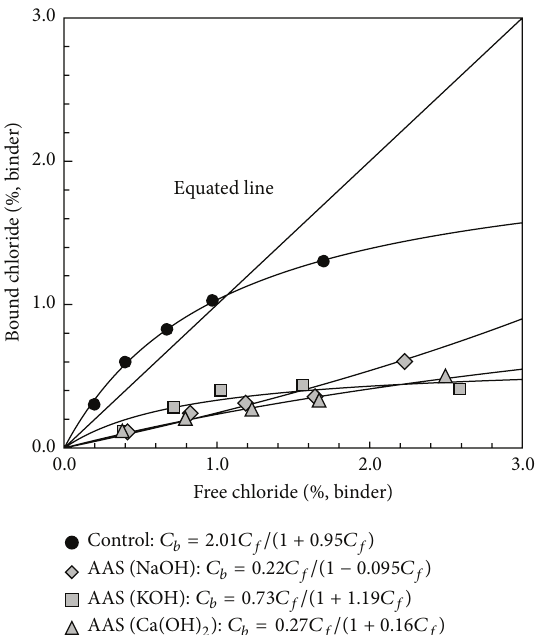
Figure 3: Langmuir isotherms between free and bound chlorides depending on activator type.